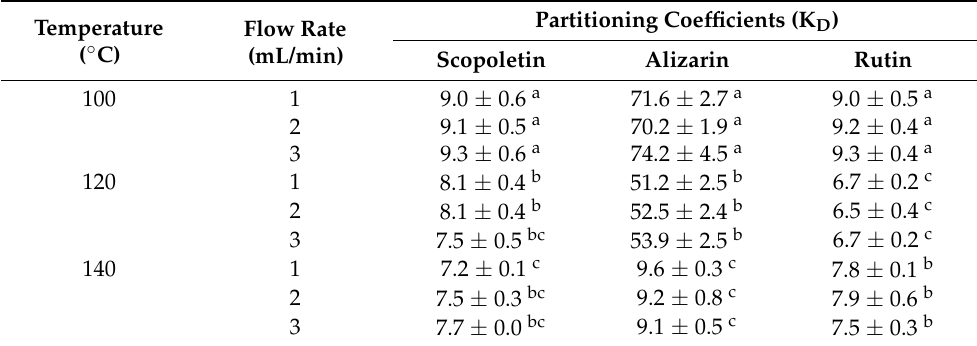
Table 2. Partitioning coefficients (K D ) of bioactive compounds extracted by subcritical water fitted by the thermodynamic partitioning